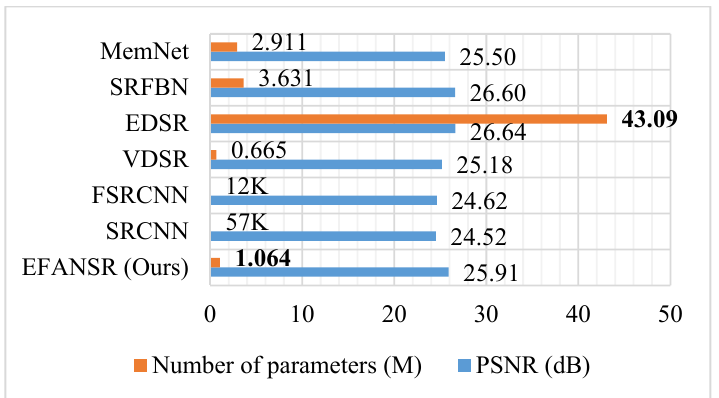
Figure 11. Comparison of the number of network parameters and the performance on the Urban100 dataset for 4× SR.